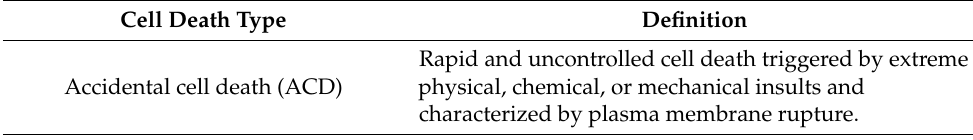
Table 2. Mechanistic classification of cell death (adapted from Galluzzi et al.; 2018)